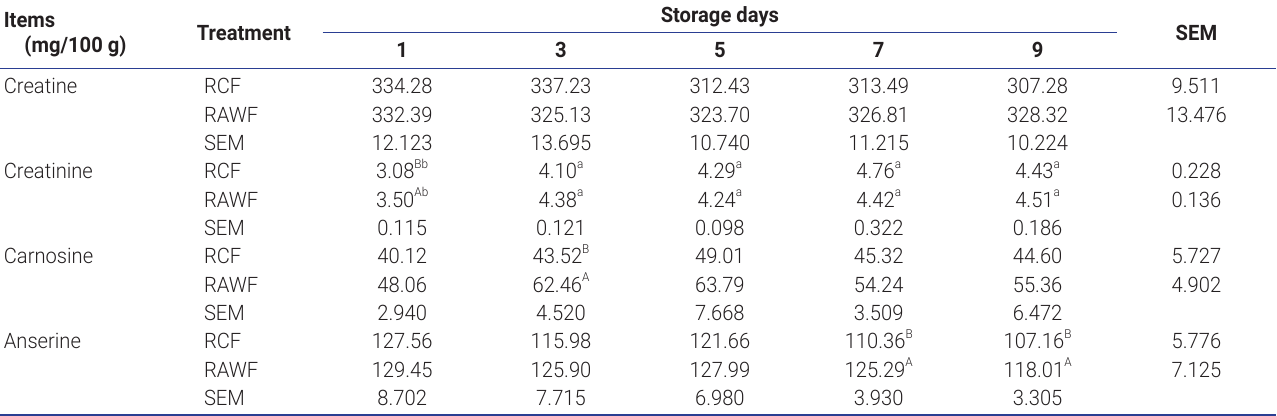
Table 5. Creatine, creatinine, carnosine, and anserine contents of thigh meat of Ross 308 broilers from conventional and animal welfare farming system during cold storage Items Treatment (mg/100 g)